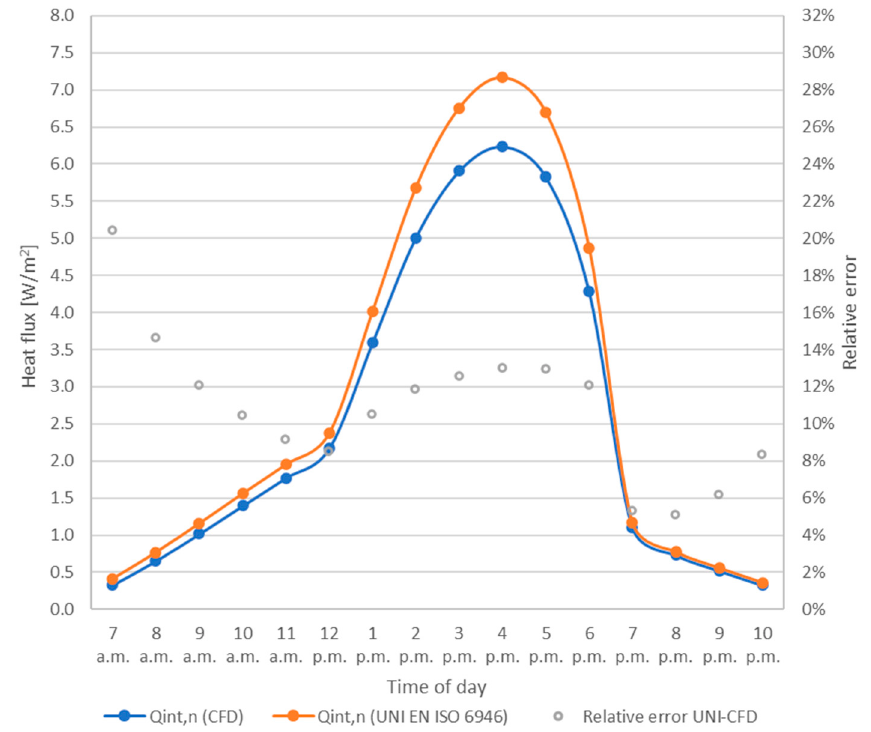
Figure 10. Comparison between the heat flux Q int,n obtained from the CFD analysis and the one calculated following the UNI EN ISO 6946 procedure referred to a well-ventilated air layer. The figure shows also the RE of the CFD results compared to the mentioned Standard at each hour.